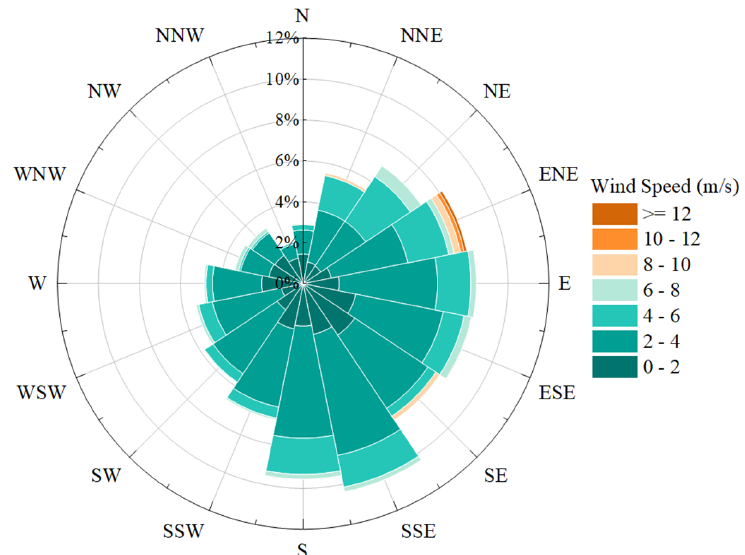
Figure 10. Wind rose derived from the analysis of wind data during the third quarter of 2021.